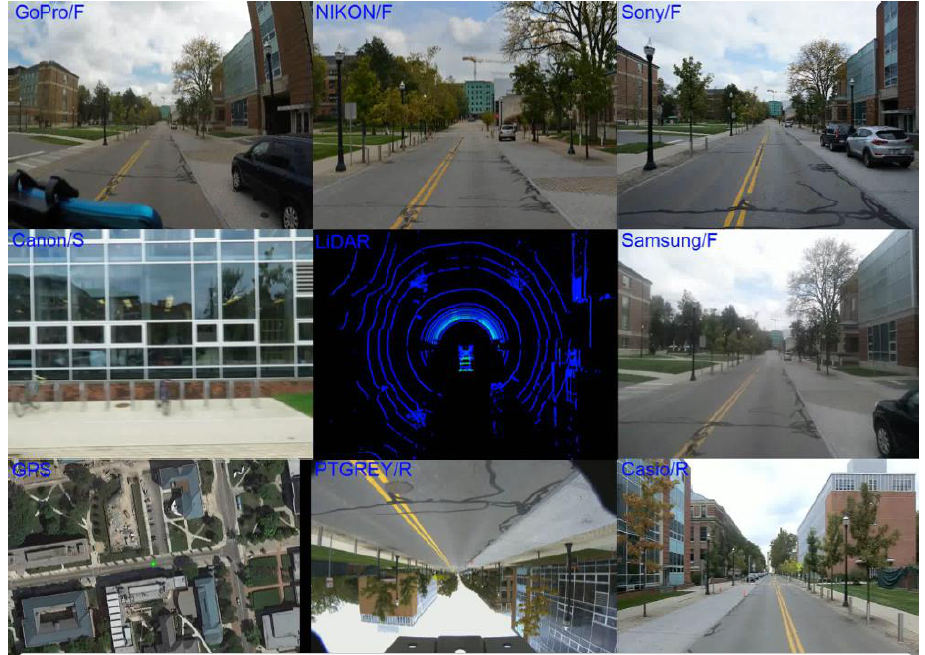
Figure 9. Data streams from GoPro (video, top left), Nikon (high resolution still images, top center), Sony (high resolution still images, top right), Canon (P&S, video, middle left), Velodyne HDL-32E (LiDAR, middle center), Samsung (mobile phone, built-in camera, middle right), GPS/GNSS (bottom left), PointGrey (video, bottom center), and Casio (P&S, video, middle right).